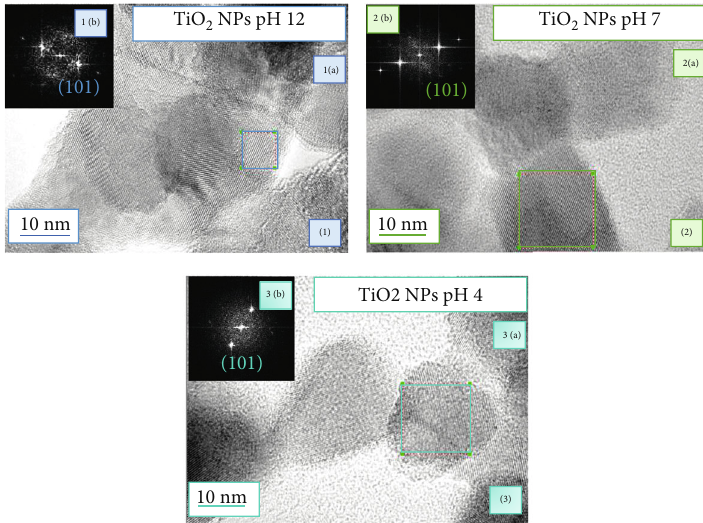
Figure 3: TEM micrographs of TiO